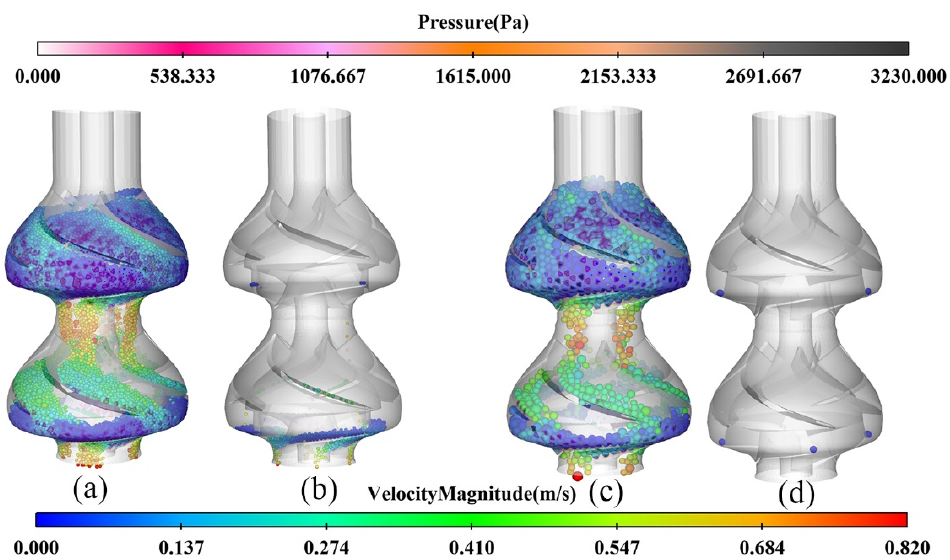
Figure 10. The movement and accumulation of 10–20 and 20–30 mm particles at the corresponding time points: ( a ) 10–20 mm particles at 10 s simulation; ( b ) 10–20 mm particles at 30 s simulation; ( c ) 20–30 mm particles at 10 s simulation; ( d ) 20–30 mm particles at 30 s simulation.